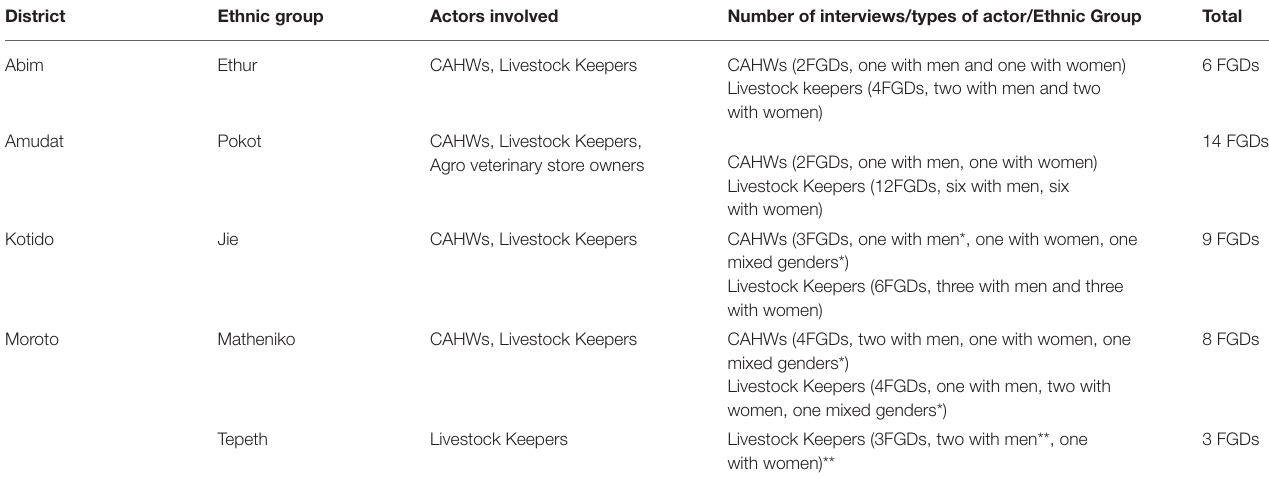
TABLE 2 | Detailed distribution of FGDs held in each district.